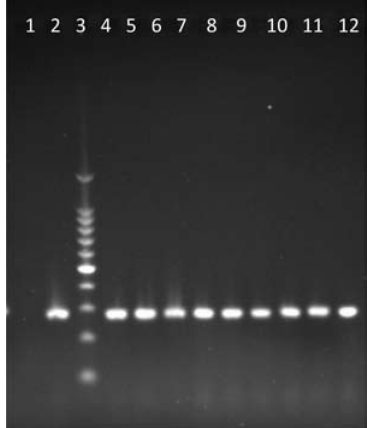
Fig. 3. Agarose electrophoresis of nuc gene specific PCR of S. aureus Lane 1 – Negative control Lane 2 - Positive